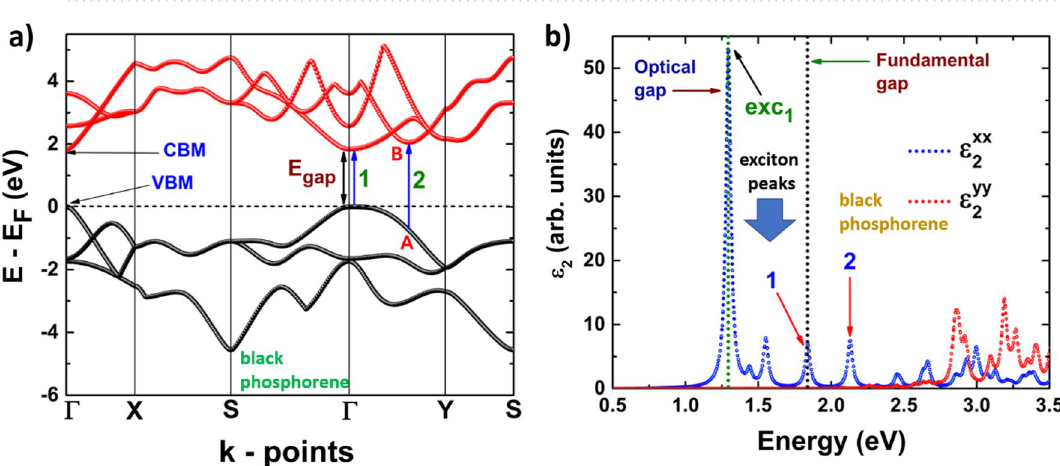
Figure 9. ( a ) Electronic band structure of black phosphorene including the information of two important direct transitions. ( b ) Dielectric function imaginary part of black phosphorene showing the values of the corresponding optical and fundamental gaps as well as exciton peaks. The peaks associated with direct transitions depicted in ( a ) are also